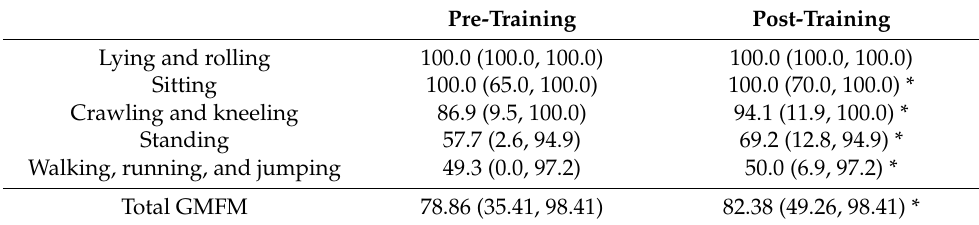
Table 2. GMFM scores at pre-and post-training time points.